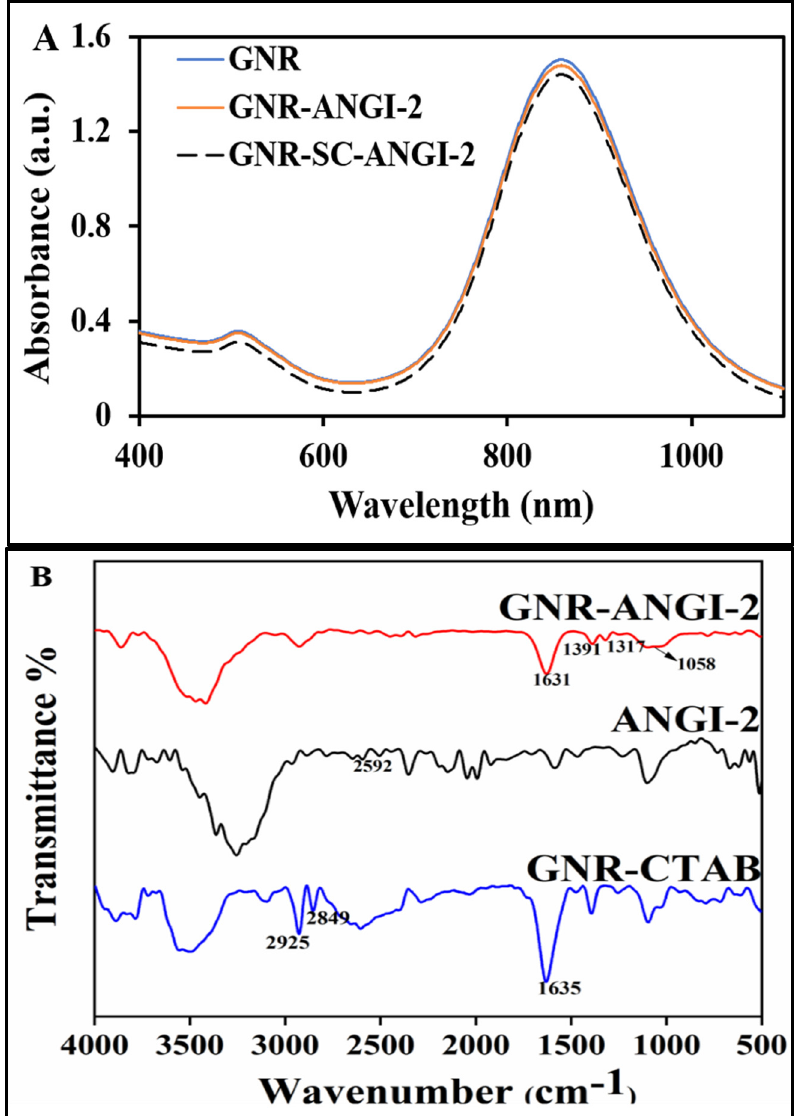
Figure 1. Characterization of GNR-CTAB and GNR-peptide conjugates. ( A ) UV–Vis absorbance spectra of GNR-CTAB, GNR-ANGI-2, and GNR-SC-ANGI-2. ( B ) FTIR spectra of GNR-CTAB, peptide, and GNR-peptide